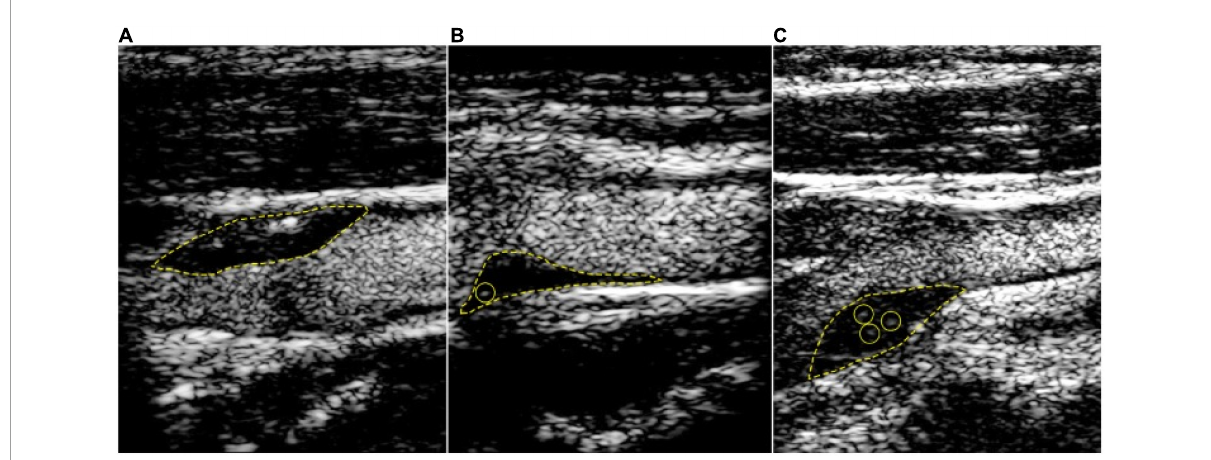
FIGURE2 Contrast-enhanced carotid ultrasound for the detection of plaque neovascularization. Content copied in its original form from Mantella et al. with permission (42). Carotid intraplaque neovascularization scoring method. Representative contrast-enhanced ultrasound images of carotid plaques. (A) demonstrates a plaque score of 0, no visible microbubbles within the plaque; (B) demonstrates a plaque score of 1, minimal microbubbles confined to peri-adventitial area; (C) demonstrates a plaque score of 2, microbubbles present throughout the plaque core. The yellow dotted line outlines the plaque lesion. Yellow circles depict intraplaque contrast